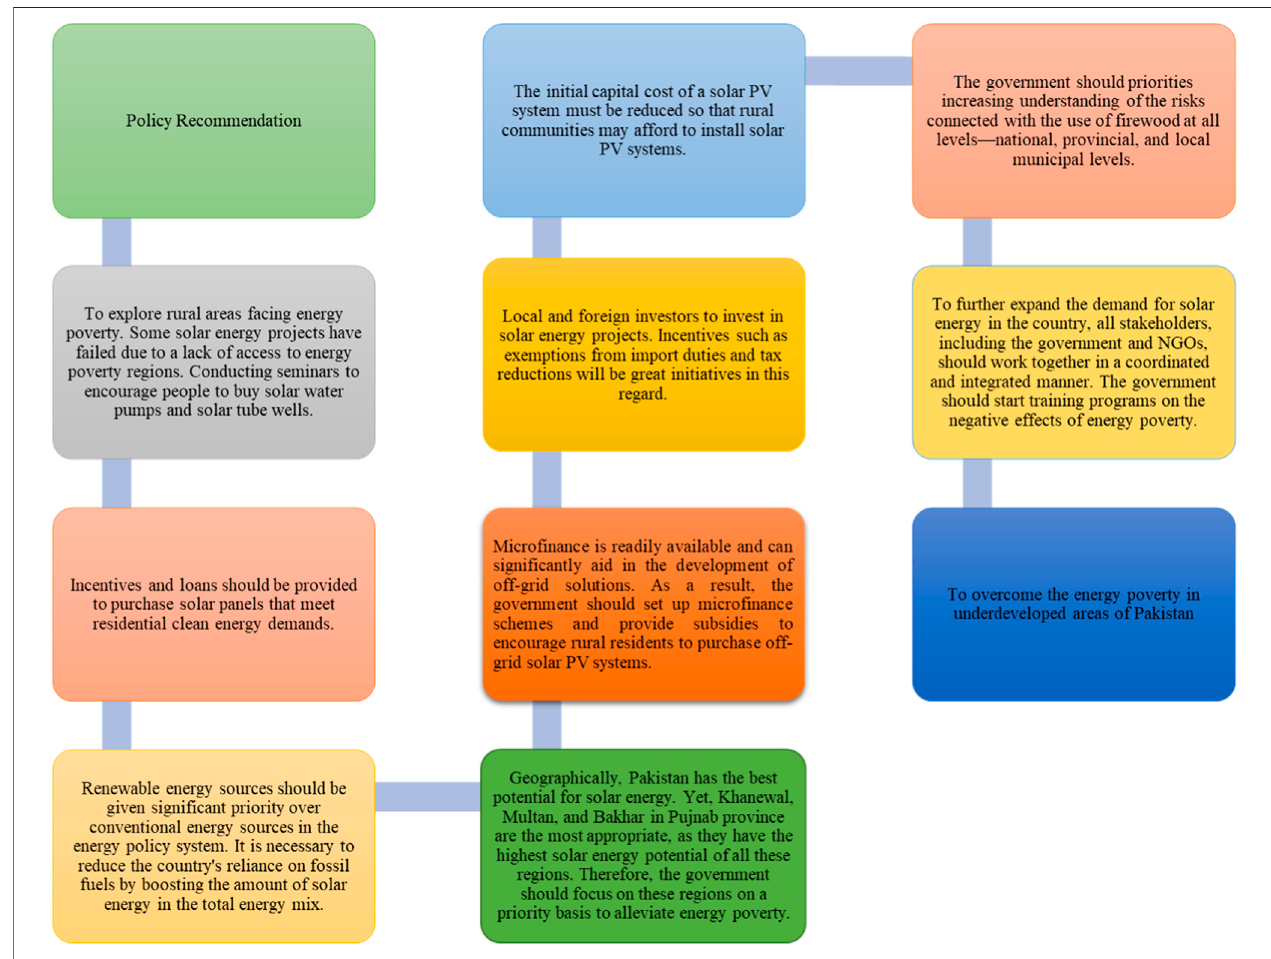
FIGURE 11 | Policy